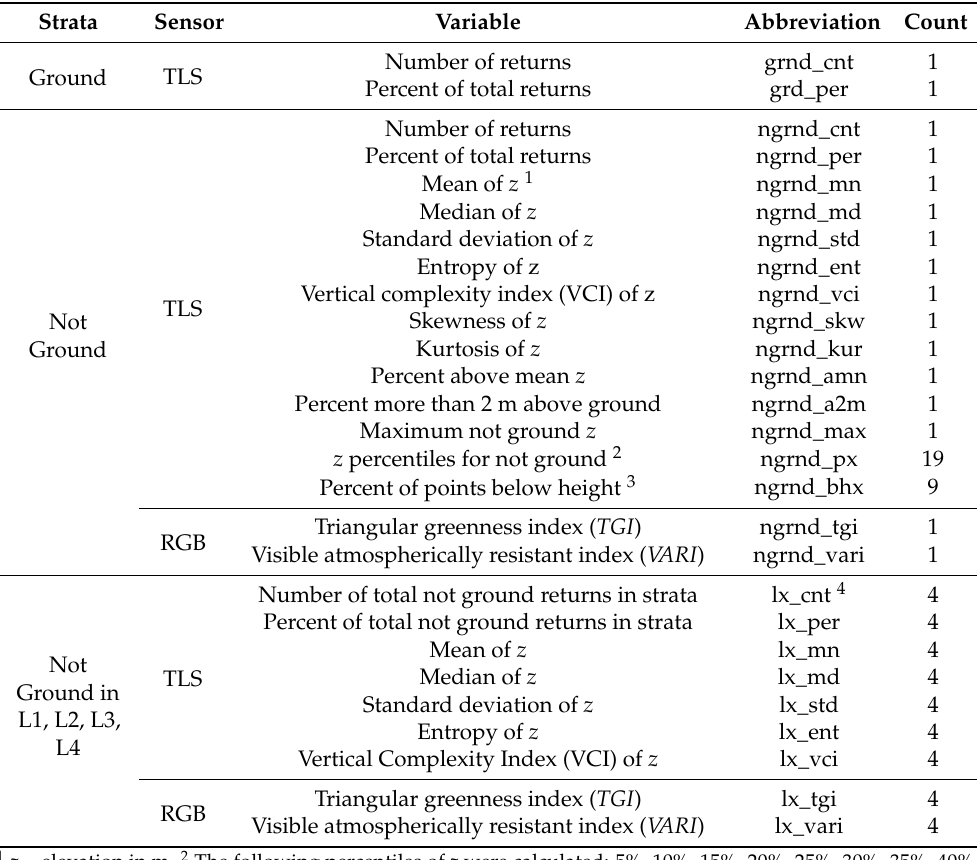
Table 2. Predictor variables generated from TLS